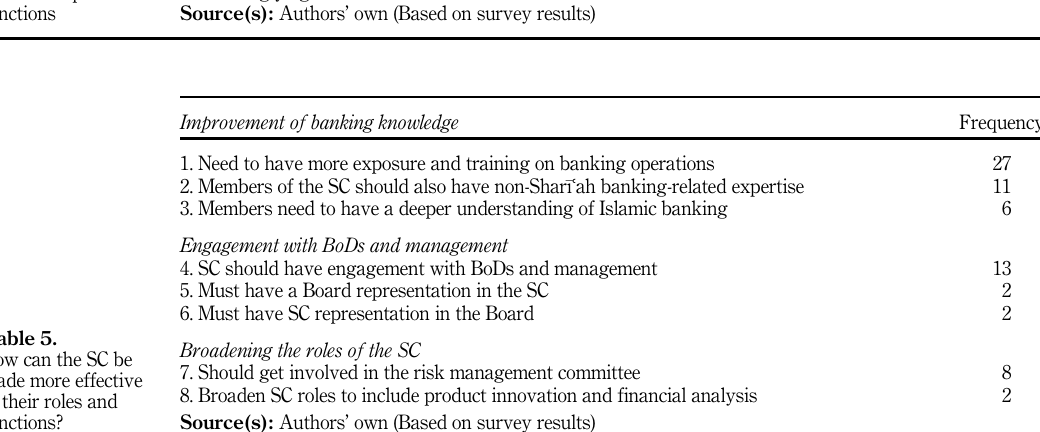
Table 4. SC perception of IBs and the scope of SC functions